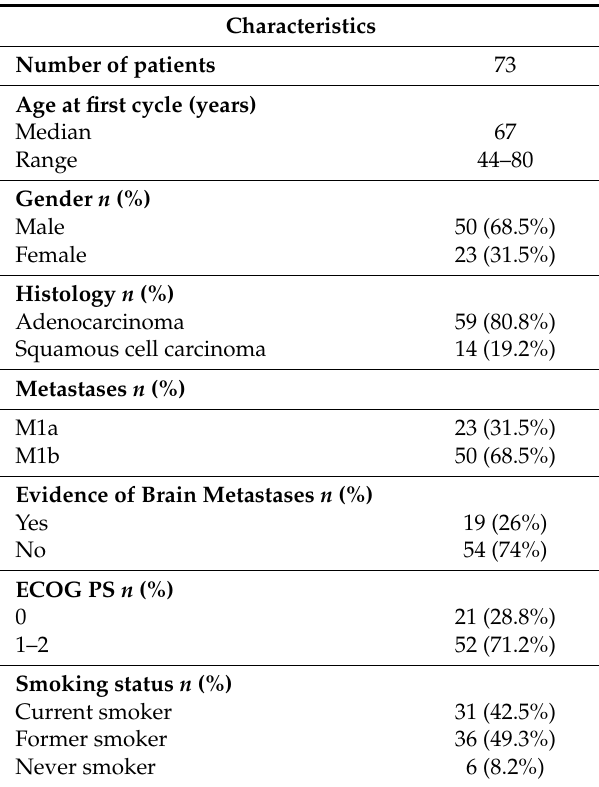
Table 1. Patients’ clinical